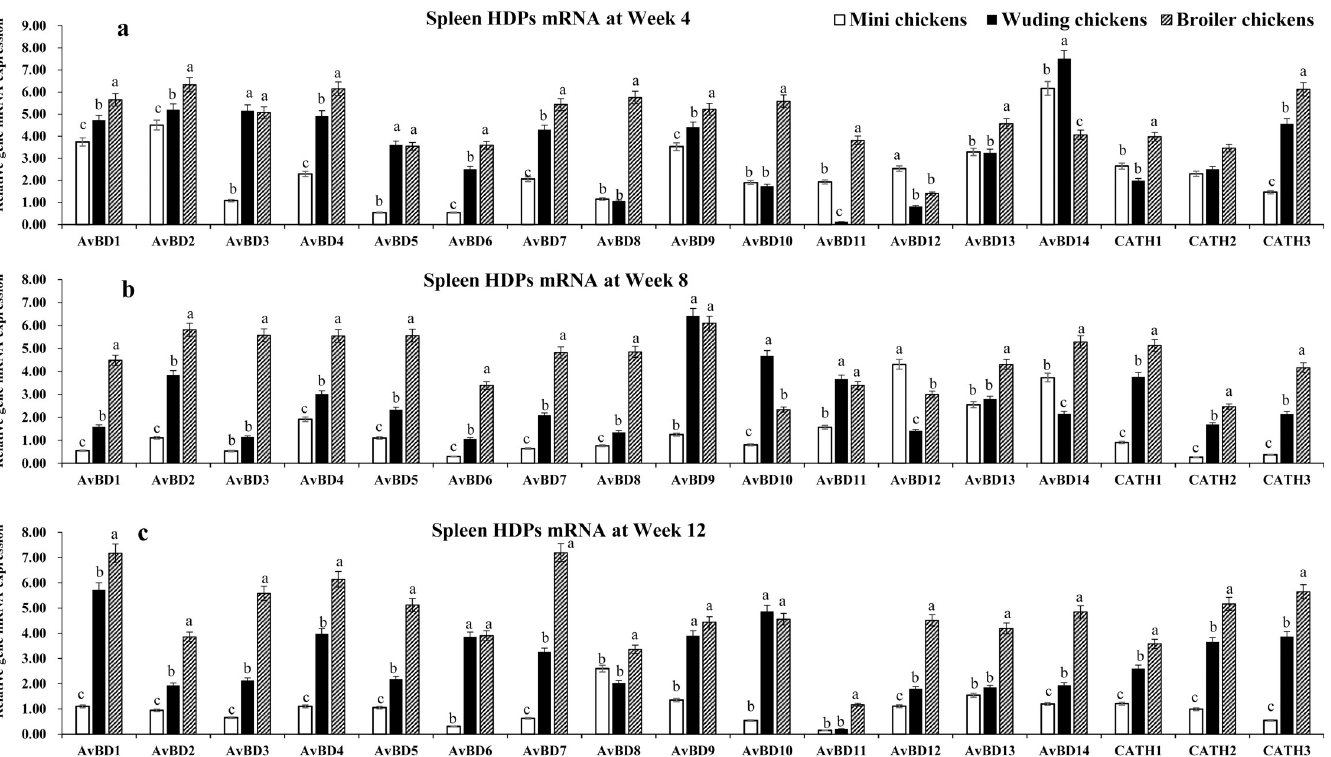
Fig 3. HDP mRNA expression in the spleen. mRNA expression of AvBD 1–14 and CATH 1–3 genes in the spleen of three chickens at weeks 4 (a), 8 (b), and 12 (c). Twenty chickens per type per time point were used and gene expression was investigated with RT-qPCR. The experiment was repeated three times. Data are expressed as the mean ± SEM at each age for each breed and different letters on top of each bar represent significant differences (p < 0.05) among chickens.